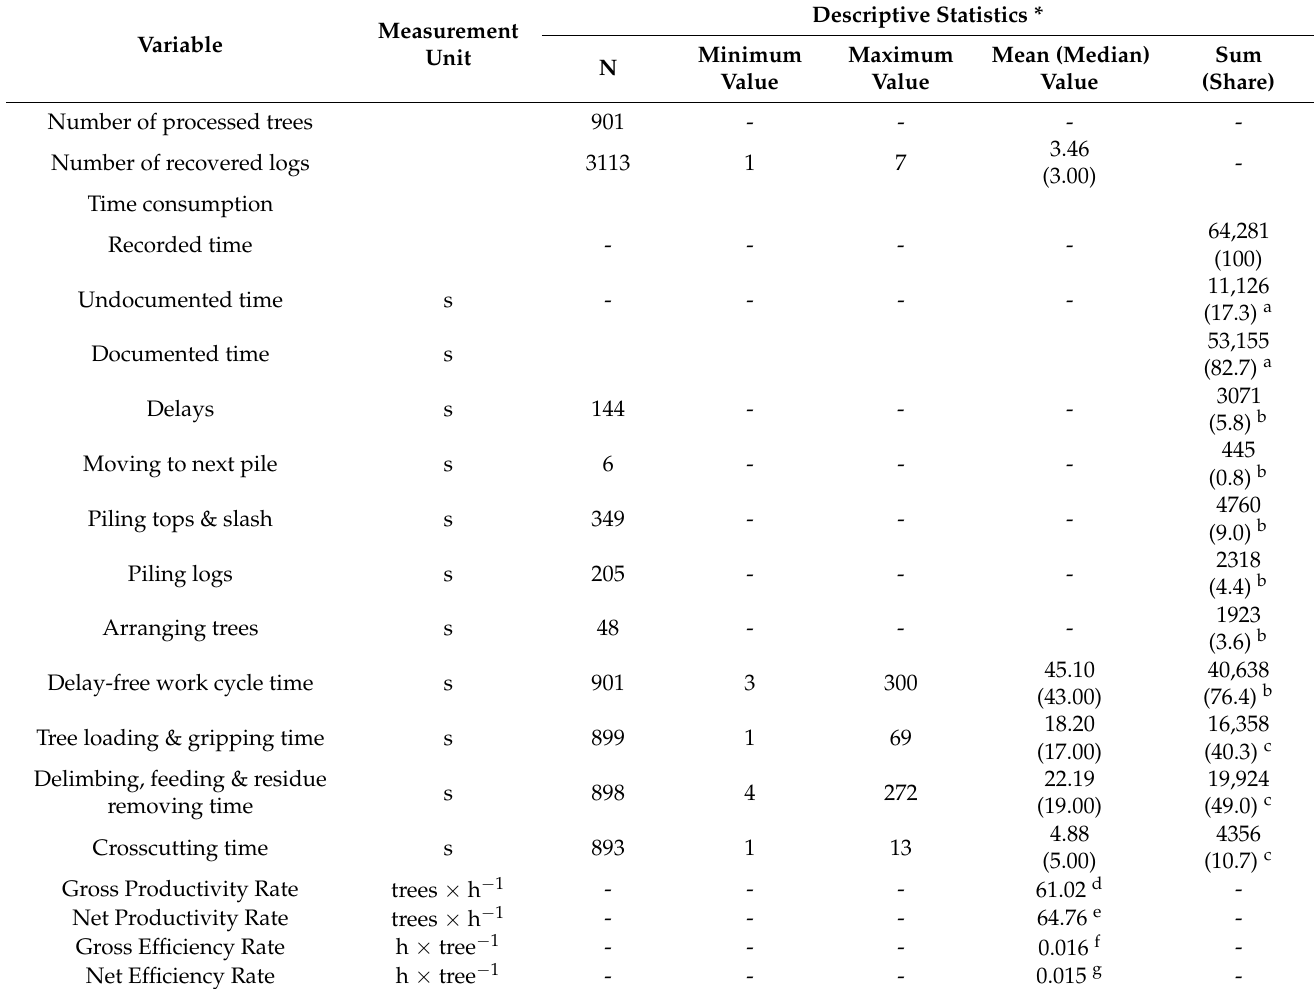
Table 2. Descriptive statistics of